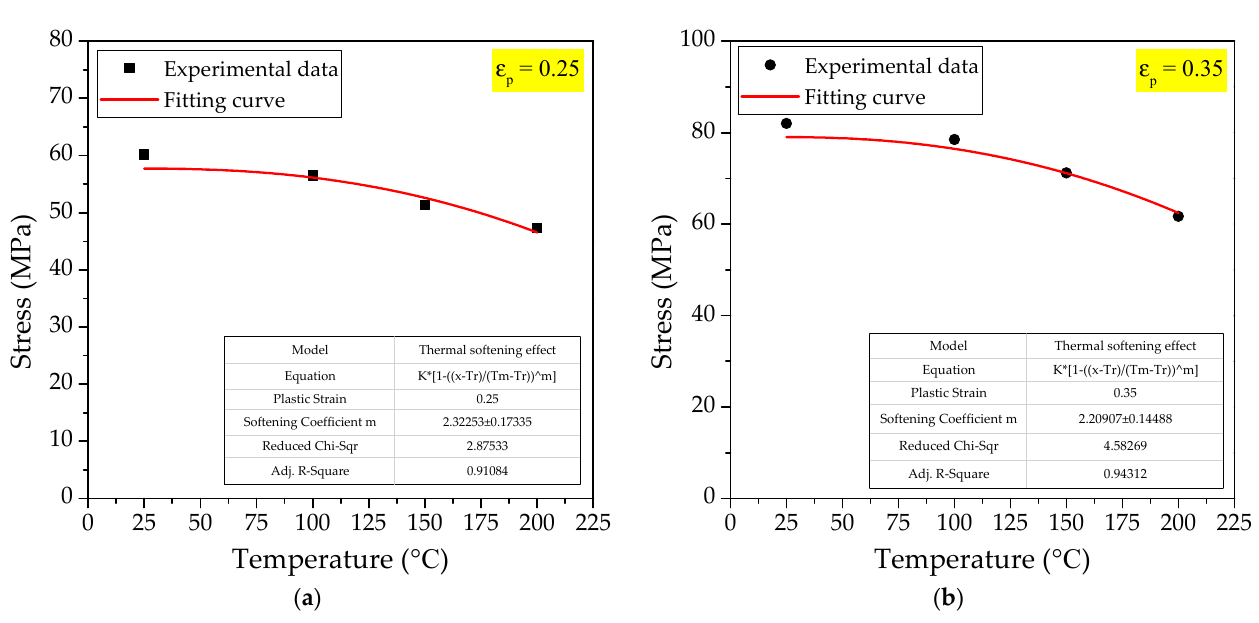
ε = 0.25; ( b ) ε = 0.35. p p